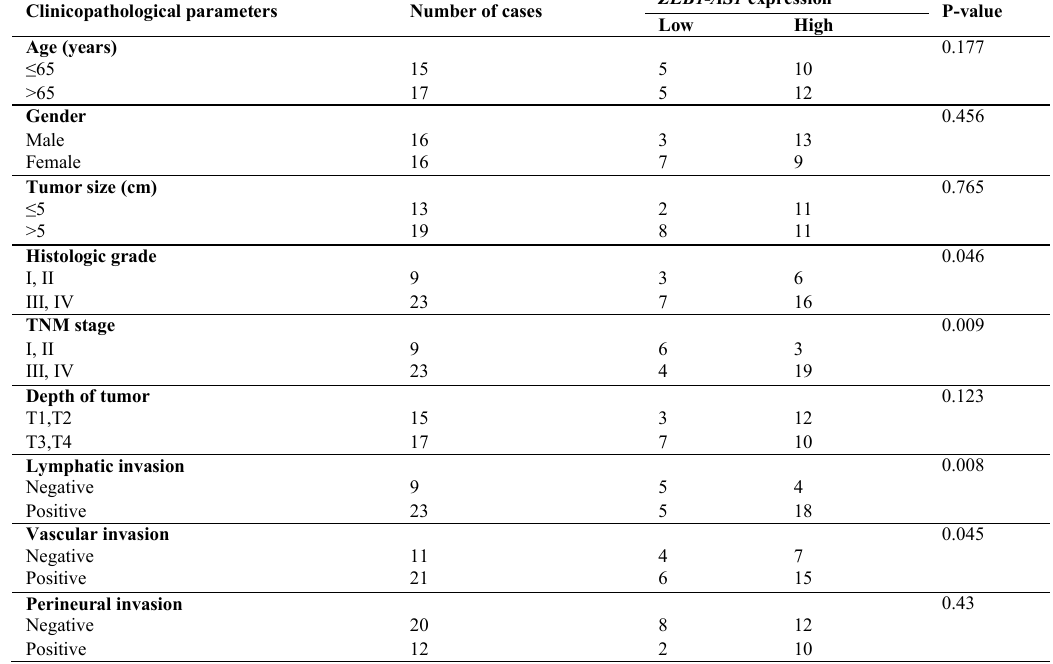
Table 1. The association of ZEB1-AS1 expression with clinicopathological factors of colorectal cancer patients Clinicopathological